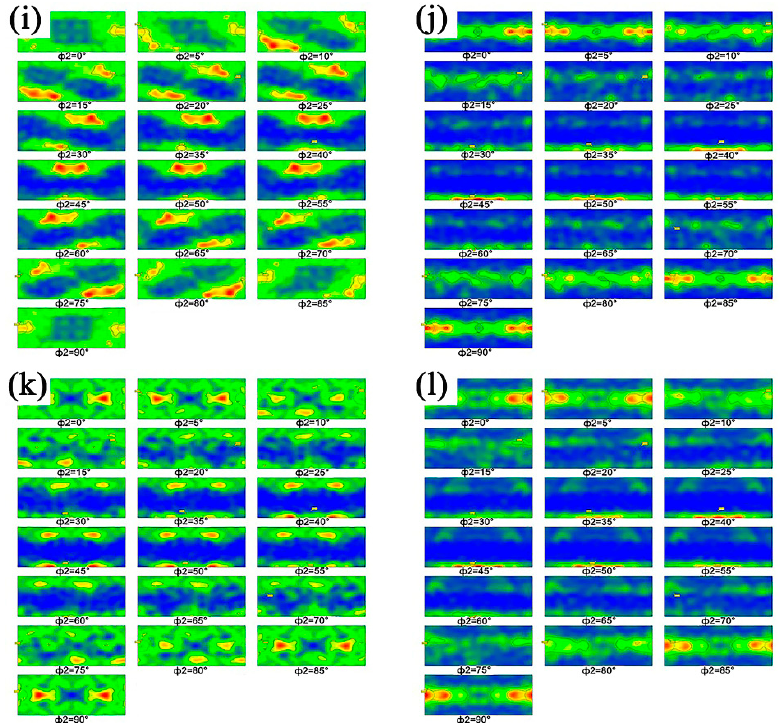
Figure 7. Three-dimensional spatial orientation distributions of grains in the surface deformation layers of bars drawn using ( a ), ( g ); ( c ), ( i ); and ( e ), ( k ) ECD, and ( b ), ( h ); ( d ), ( j ); and ( f ), ( l ) DIA for ( a ), ( g ), ( b ), ( h ) 3; ( c ), ( i ), ( d ), ( j ) 5; and ( e ), ( k ), ( f ), ( l ) 7 passes.